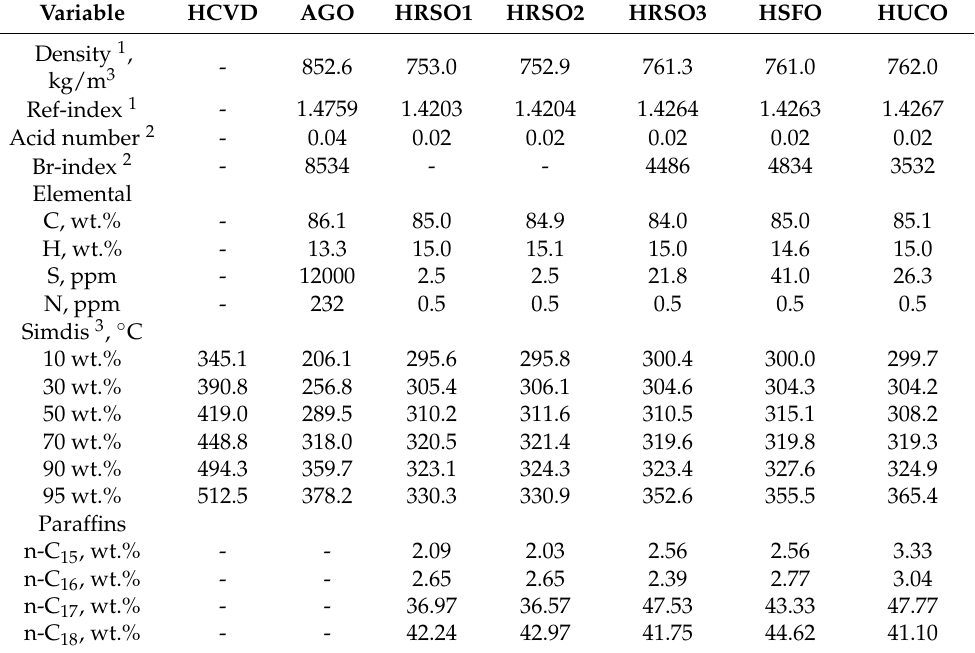
Table 3. Basic properties of traditional (HCVD and AGO) and HVOs (hydrotreated rapeseed oil HRSOx, hydrotreated sunflower oil HSFO and hydrotreated used cooking oil HUCO) feedstock for pyrolysis